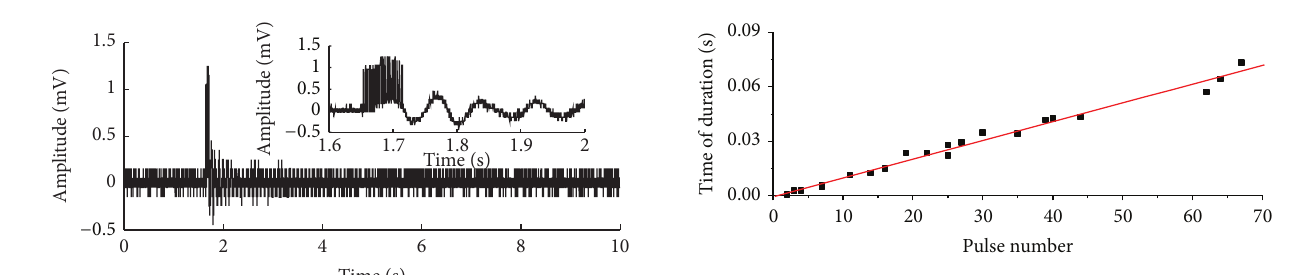
Figure 11: Relationship between 𝑁